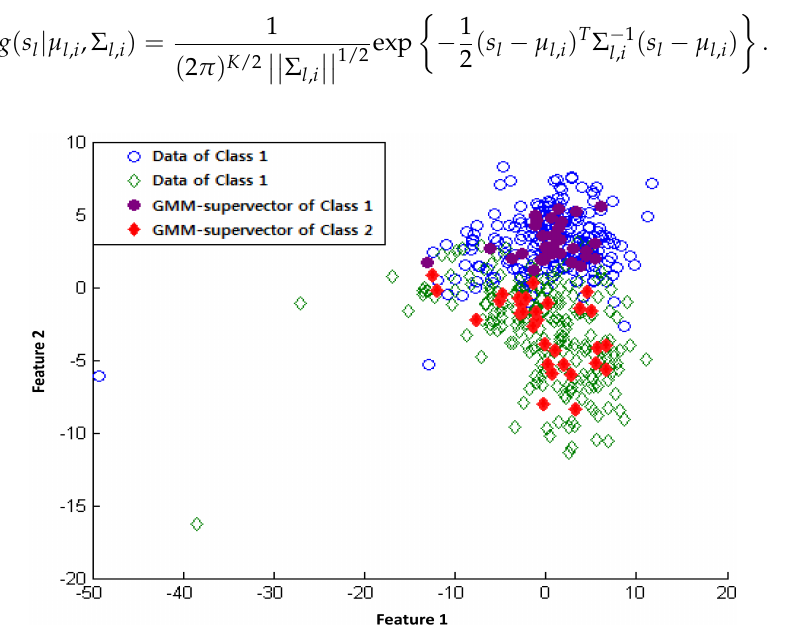
Figure 2. GMM-supervector for two features for Subject 7 in dataset IIb of the BCI competition